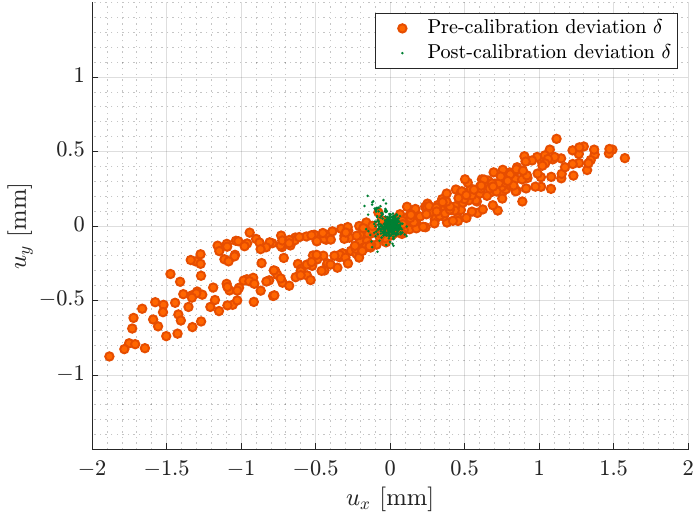
Figure 8. Comparison of positional deviations pre- and post-calibration.